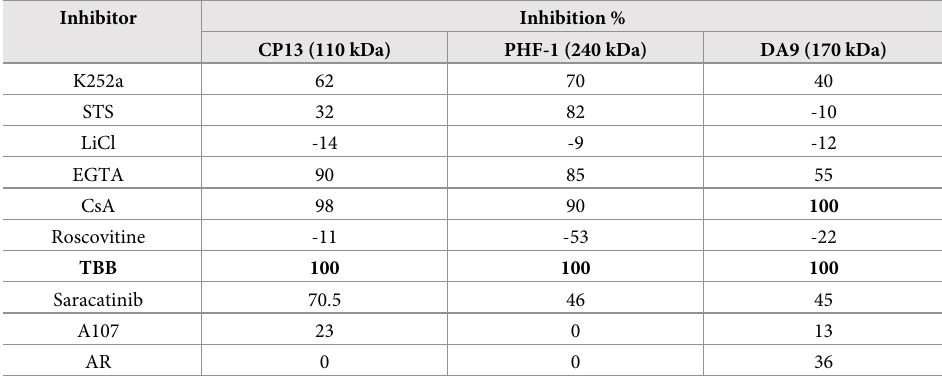
A negative sign correspond to an adverse effect. Bold corresponds to maximal inhibition at the tested